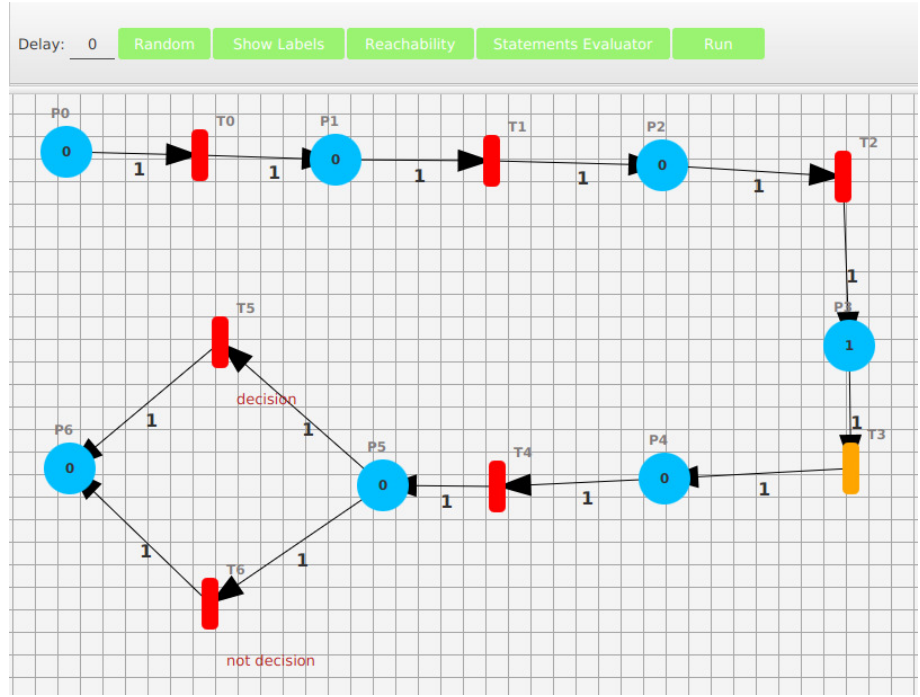
Figure 2. A snapshot of the tool showing a state of the grading